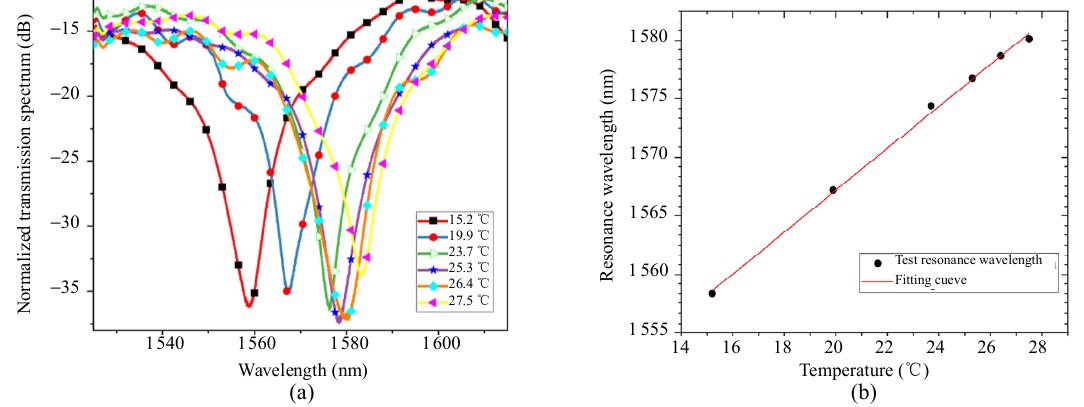
Fig. 7 Transmission spectrum of the fabricated device: (a) normalized transmission spectra at different temperatures and (b) fitting curve of temperature and central resonance